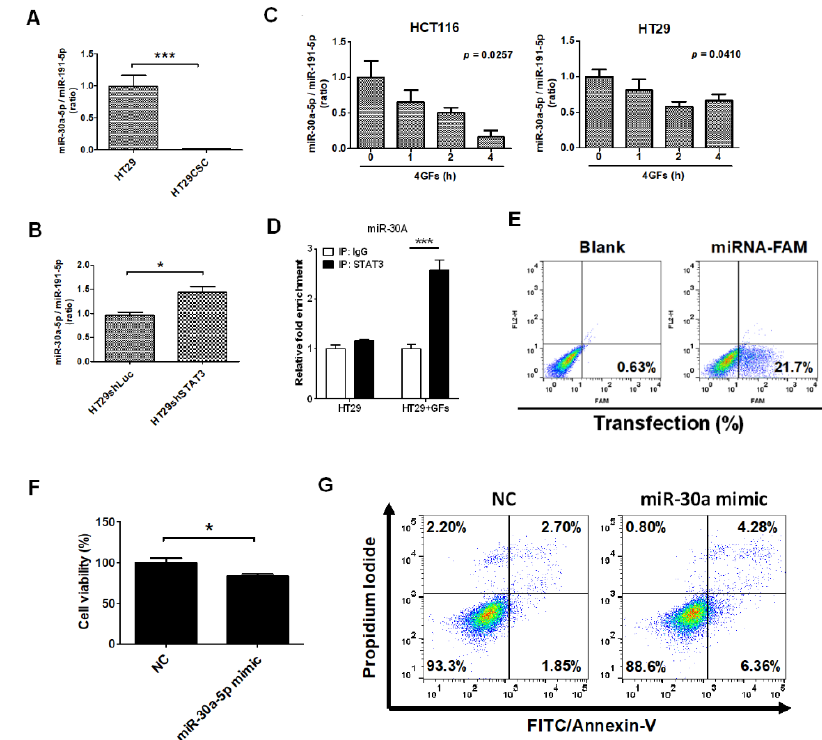
Figure 4. STAT3 downregulated miR-30a expression in CRC-derived stem-like cells. ( A ) miR-30a-5p levels were significantly decreased in HT29CSC ( B ) but increased in HT29shSTAT3 cells. ( C ) Treatment with 20 ng / mL of combined EGF, FGF, HGF, and IL-6 significantly reduced the miR-30a expression level in HCT116 and HT29 cells. ( D ) ChIP analysis indicated that STAT3 targeted the promoter of miR-30a. ( E ) Flow cytometry analysis of HT29 cells with miR-30a-5p transfection. miR-30a significantly reduced cell viability ( F ) and promoted cell apoptosis ( G ) at a transfection efficiency of < 21.7%. * p < 0.01, *** p < 0.001.